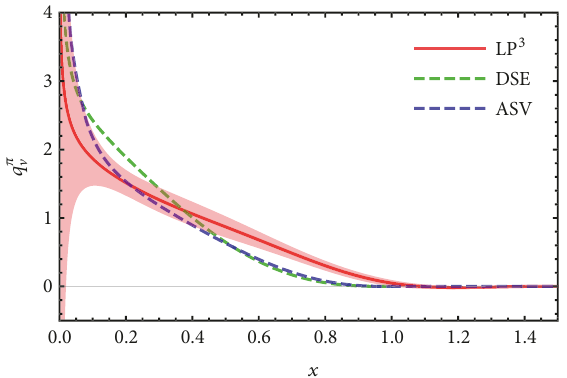
Figure 30: Pion PDF obtained in [226] from the quasidistribution approach with 𝑃 3 ≈ 1.74 GeV, 𝜇 = 4 GeV (“LP 3 ”), together with model calculation from Dyson-Schwinger equations at 𝜇 = 5.2